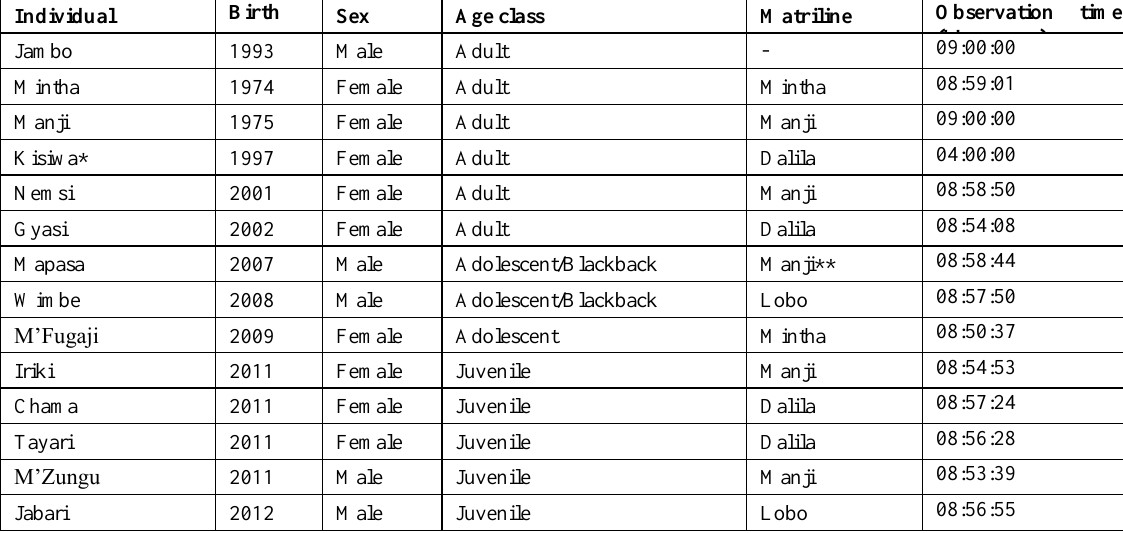
Characteristics of Study Subjects and Total Observation Time